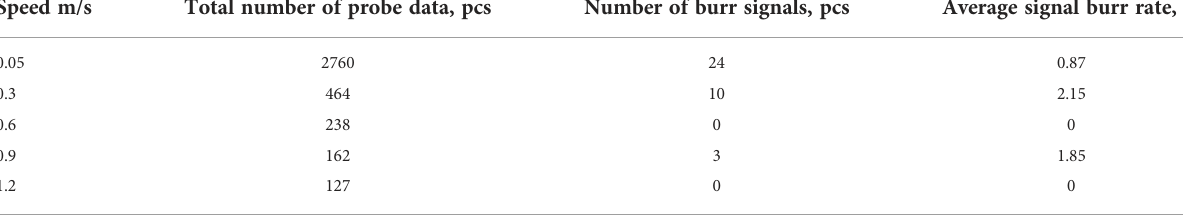
TABLE 5 Signal glitch rate of ultrasonic sensors on fi eld